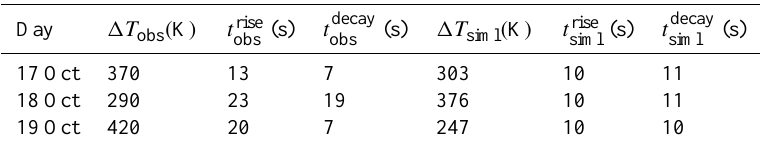
Table 1. Observed and simulated